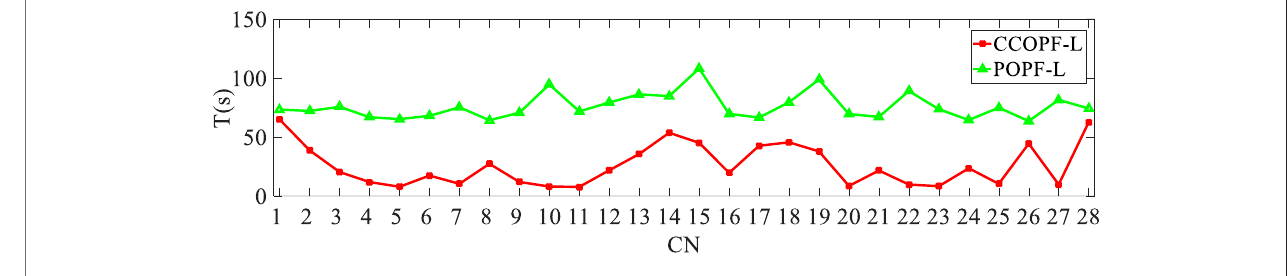
FIGURE 13 | Running time of the two OPF-based methods.